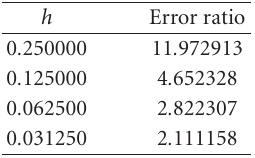
(cid:21) 1 on Fresnel’s elasticity